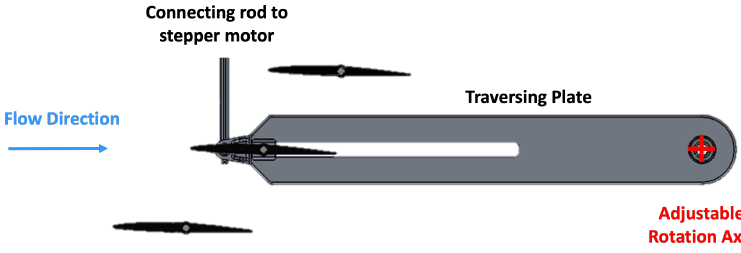
Figure 6. Section view of the vibrating blade module implementation of x / c